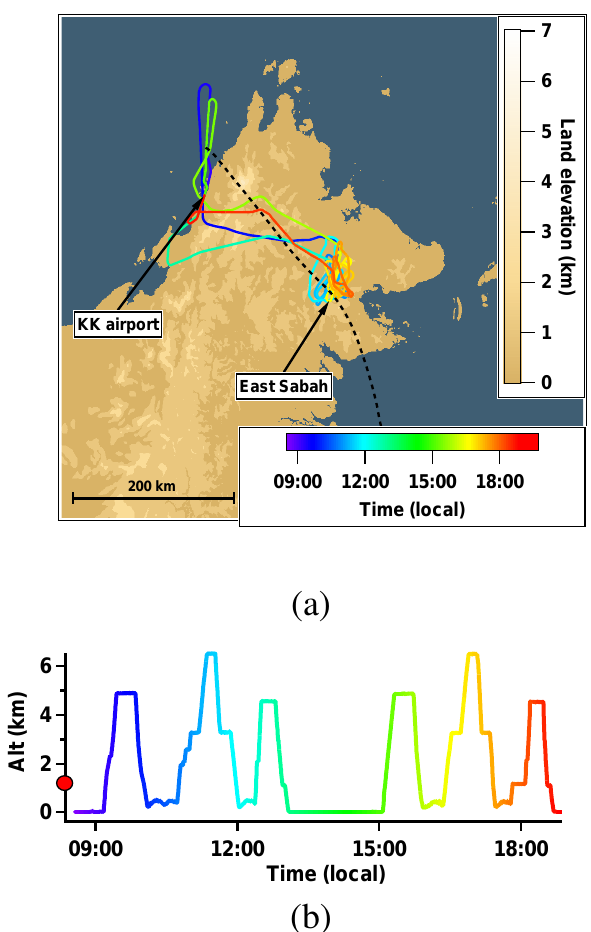
Fig. 1. Typical research flights B385a and b on the 11 July 2008. (a) topographic map of Borneo with flight track coloured by time. Kota Kinabalu (KK) airport and “East Sabah” are indicated. A typical back trajectory is marked by the dashed black line. Air mass is moving from east to west and has a transit time of ∼ 30 h from coast to coast. (b) Flight altitude showing a series profiles interrupted by straight and level runs. The red dot on the y -axis marks the trajectory release altitude of 880 hPa or 1.26 km (above the well mixed surface layer) descending to around 903 hPa upwind of Borneo. Both plots have lines coloured on the same time scale.